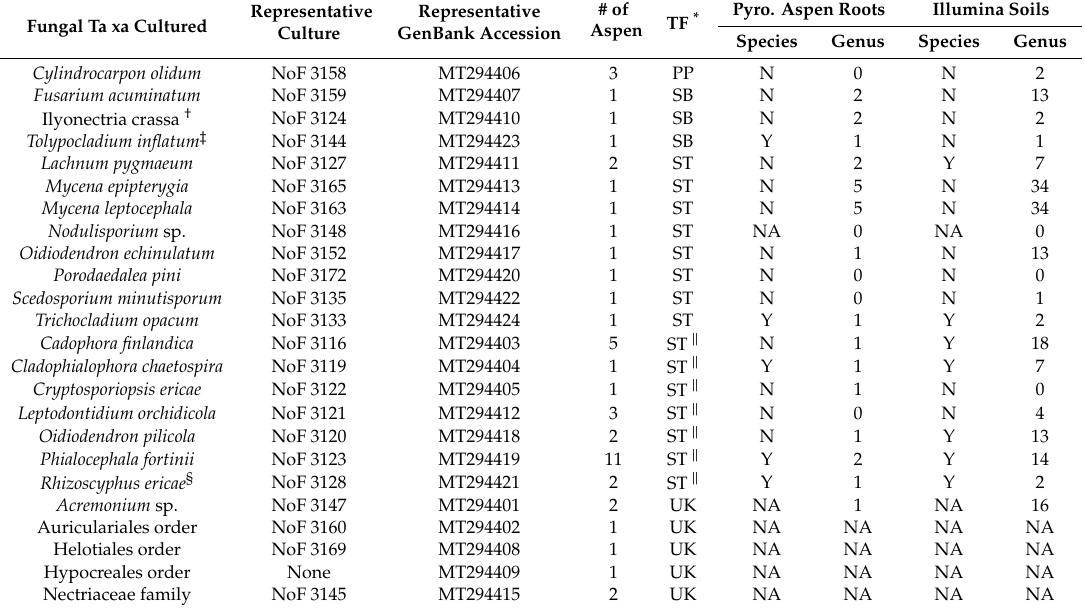
Table 1. Fungal taxa cultured from aspen roots and identified with Sanger sequencing. Representative isolates have been deposited in the culture collection of the Northern Forestry Centre (NoF) GenBank accession number of representative isolate, with data on the number of young aspen from which cultures were isolated (maximum 11), the associated trophic function (TF), and whether taxa were detected at the level of species (Y = exact match, N = no match, NA = Cultured taxa not identified to species or genus) or genus (number of taxa) in 454 pyrosequencing of communities in aspen roots (Pyro. aspen roots). Results from Illumina sequencing of communities are also shown for soils sampled in 2016 (Illumina